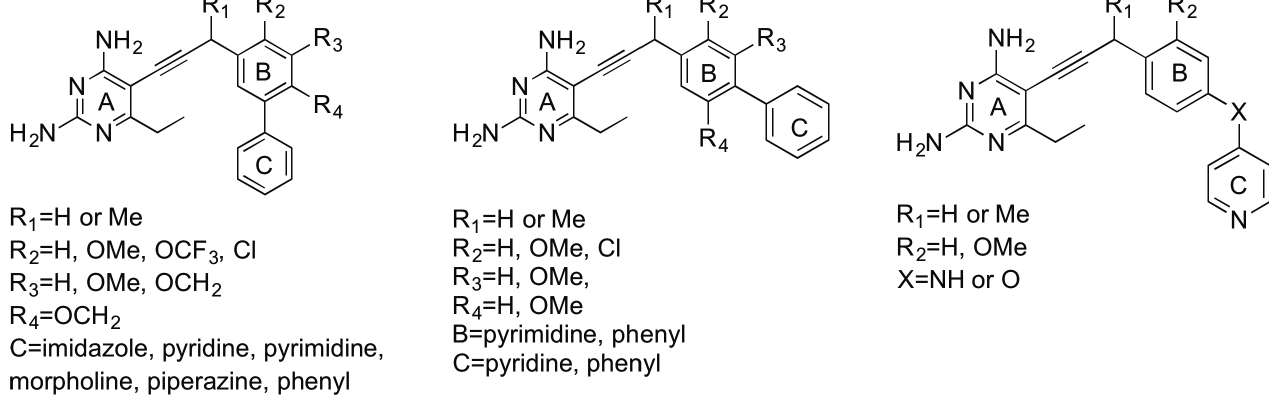
Fig 1. Examples of propargyl-linked antifolates evaluated for antibacterial activity.